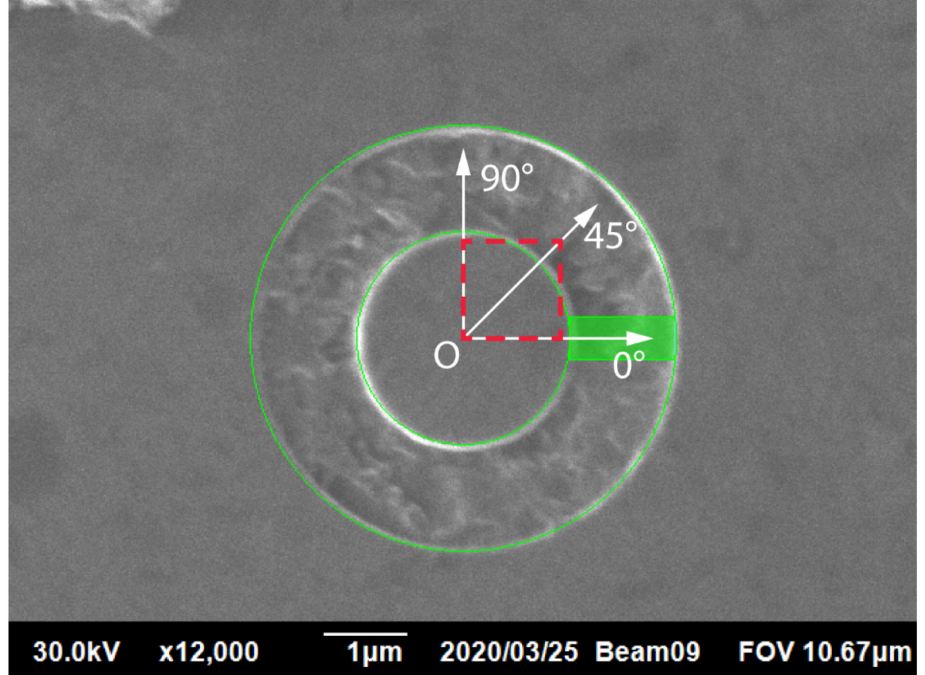
Figure 7. The quarter area which was selected to calculate the residual stress by THE FIB–DIC method.